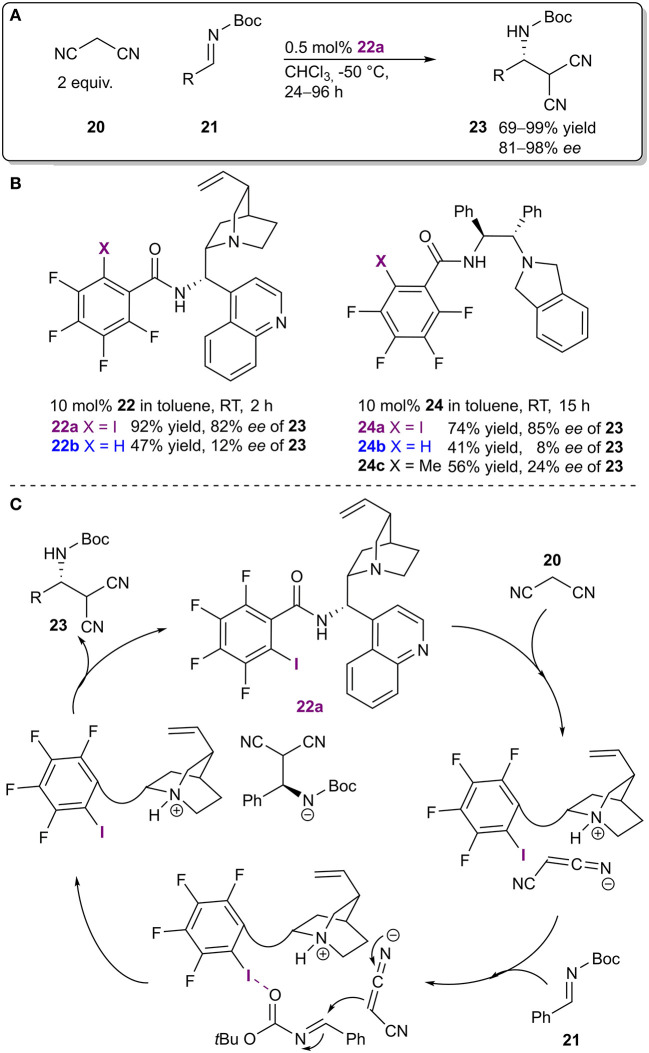
(A) Enantioselective Mannich reaction; (B) catalysts probed to determine the influence of the halogen atom on the reaction; (C) proposed catalytic cycle.